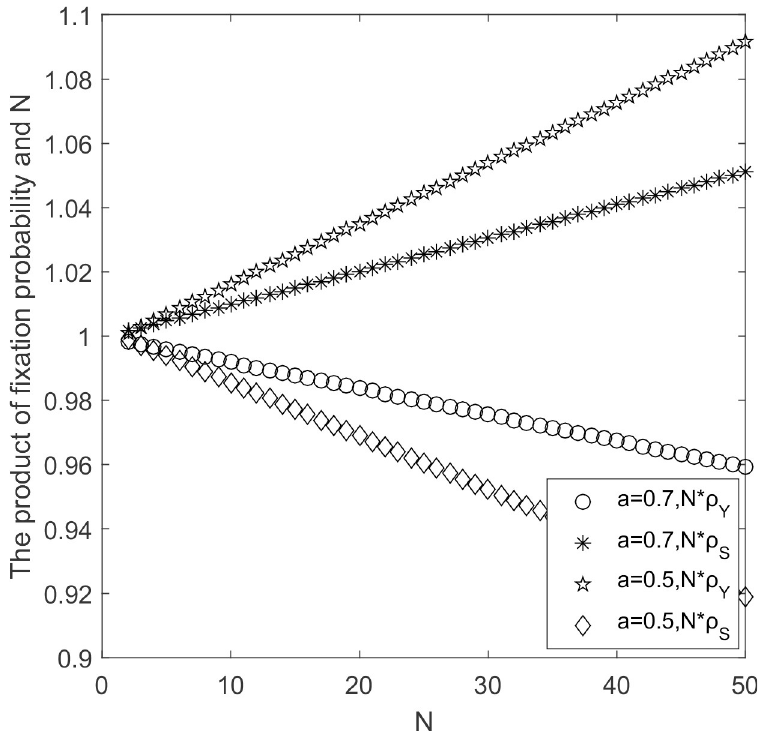
Fig 5. N � ρ Y /N � ρ S ~ a change